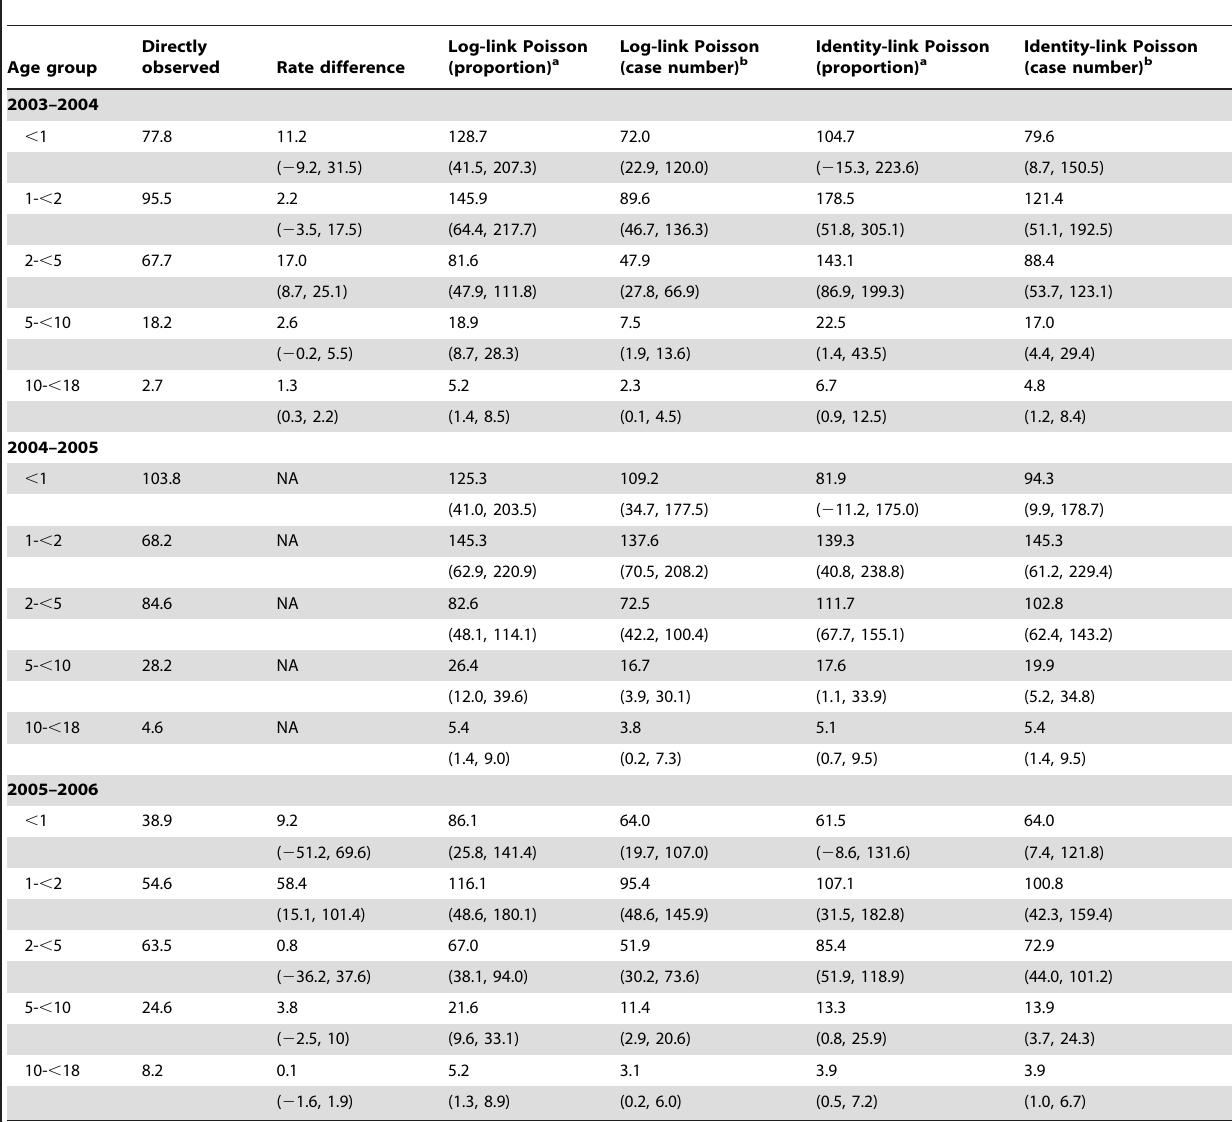
Table 1. Comparison of influenza associated ARD hospitalization rate (per 10,000) estimated from the rate difference model, log- link Poisson and identity-link Poisson regression models with virologically confirmed hospitalization (Directly observed) in patients , 18 years on Hong Kong